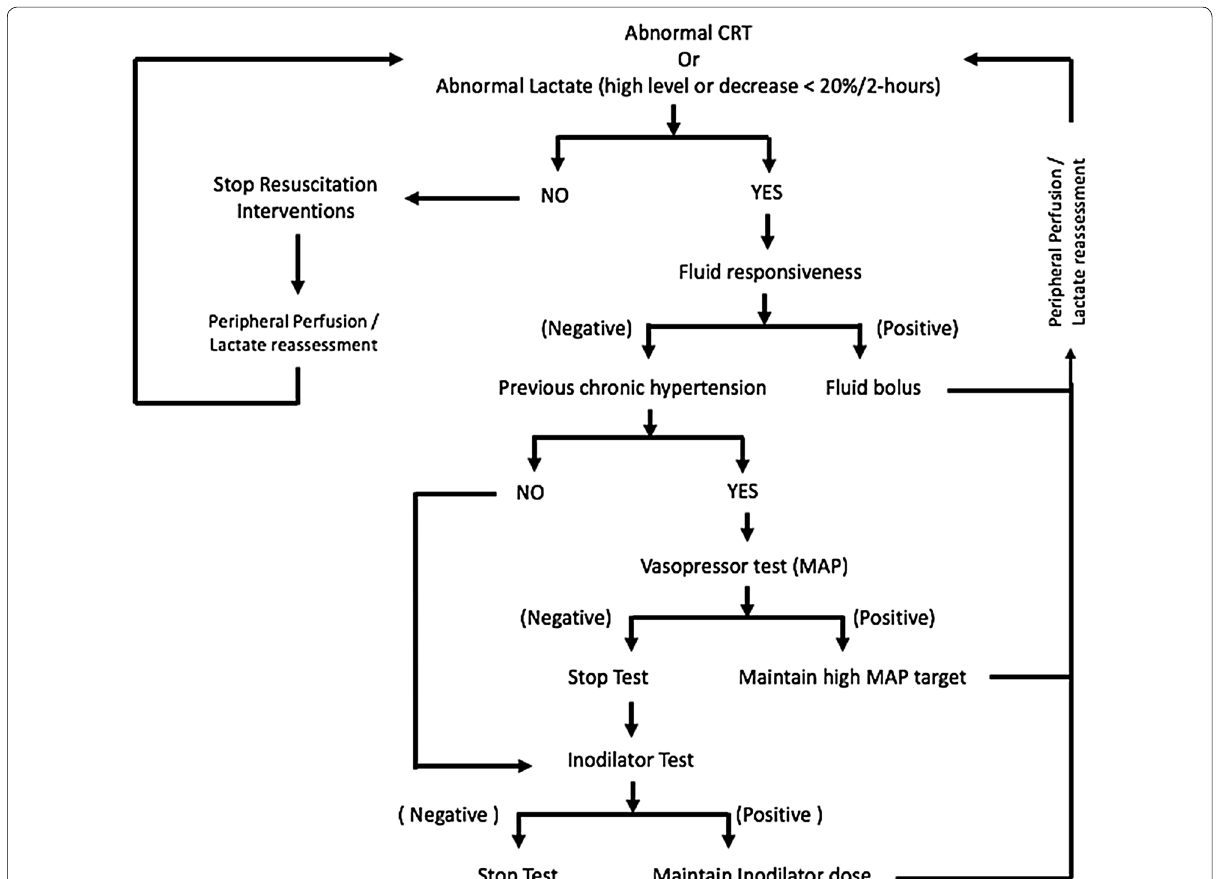
Fig. 2 Resuscitation protocol for both groups. The figure describes the sequential approach to resuscitation. The process starts with fluid loading according to the status of fluid responsiveness. If the goal is not obtained, the second step is a vasopressor test, and then an inodilator test. CRT, capillary refill